Question: Which kind of chart has been used to present this data?
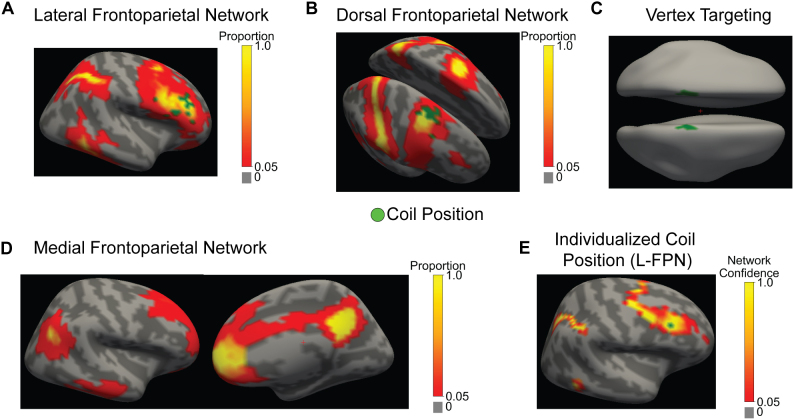
Answer: heatmap